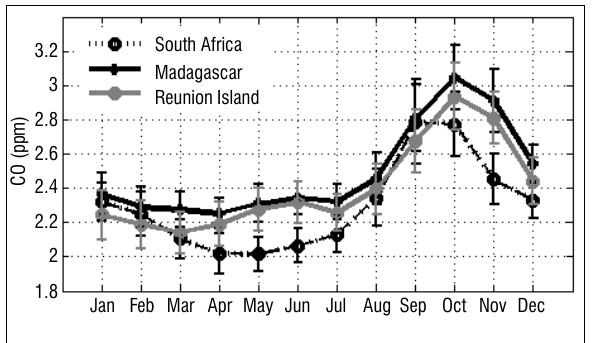
Monthly distribution of CO and the trends estimated for the period from January 2005 to December 2009.